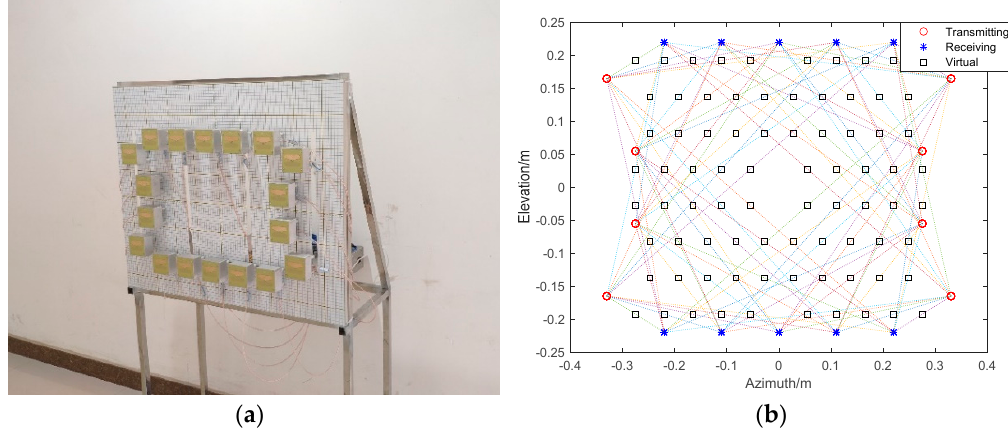
Figure 15. The experimental MIMO radar; ( a ) the photo; ( b ) the topology of the antenna array.